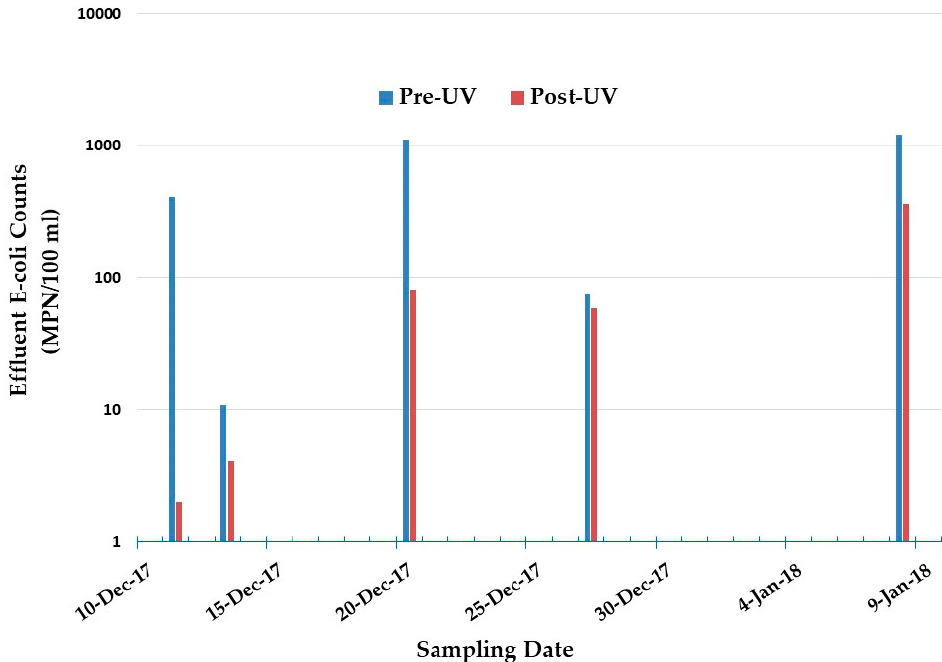
Figure 8. The E-coli counts collected from 11 December 2017 to 8 January 2018 prior- and post-UV disinfection.